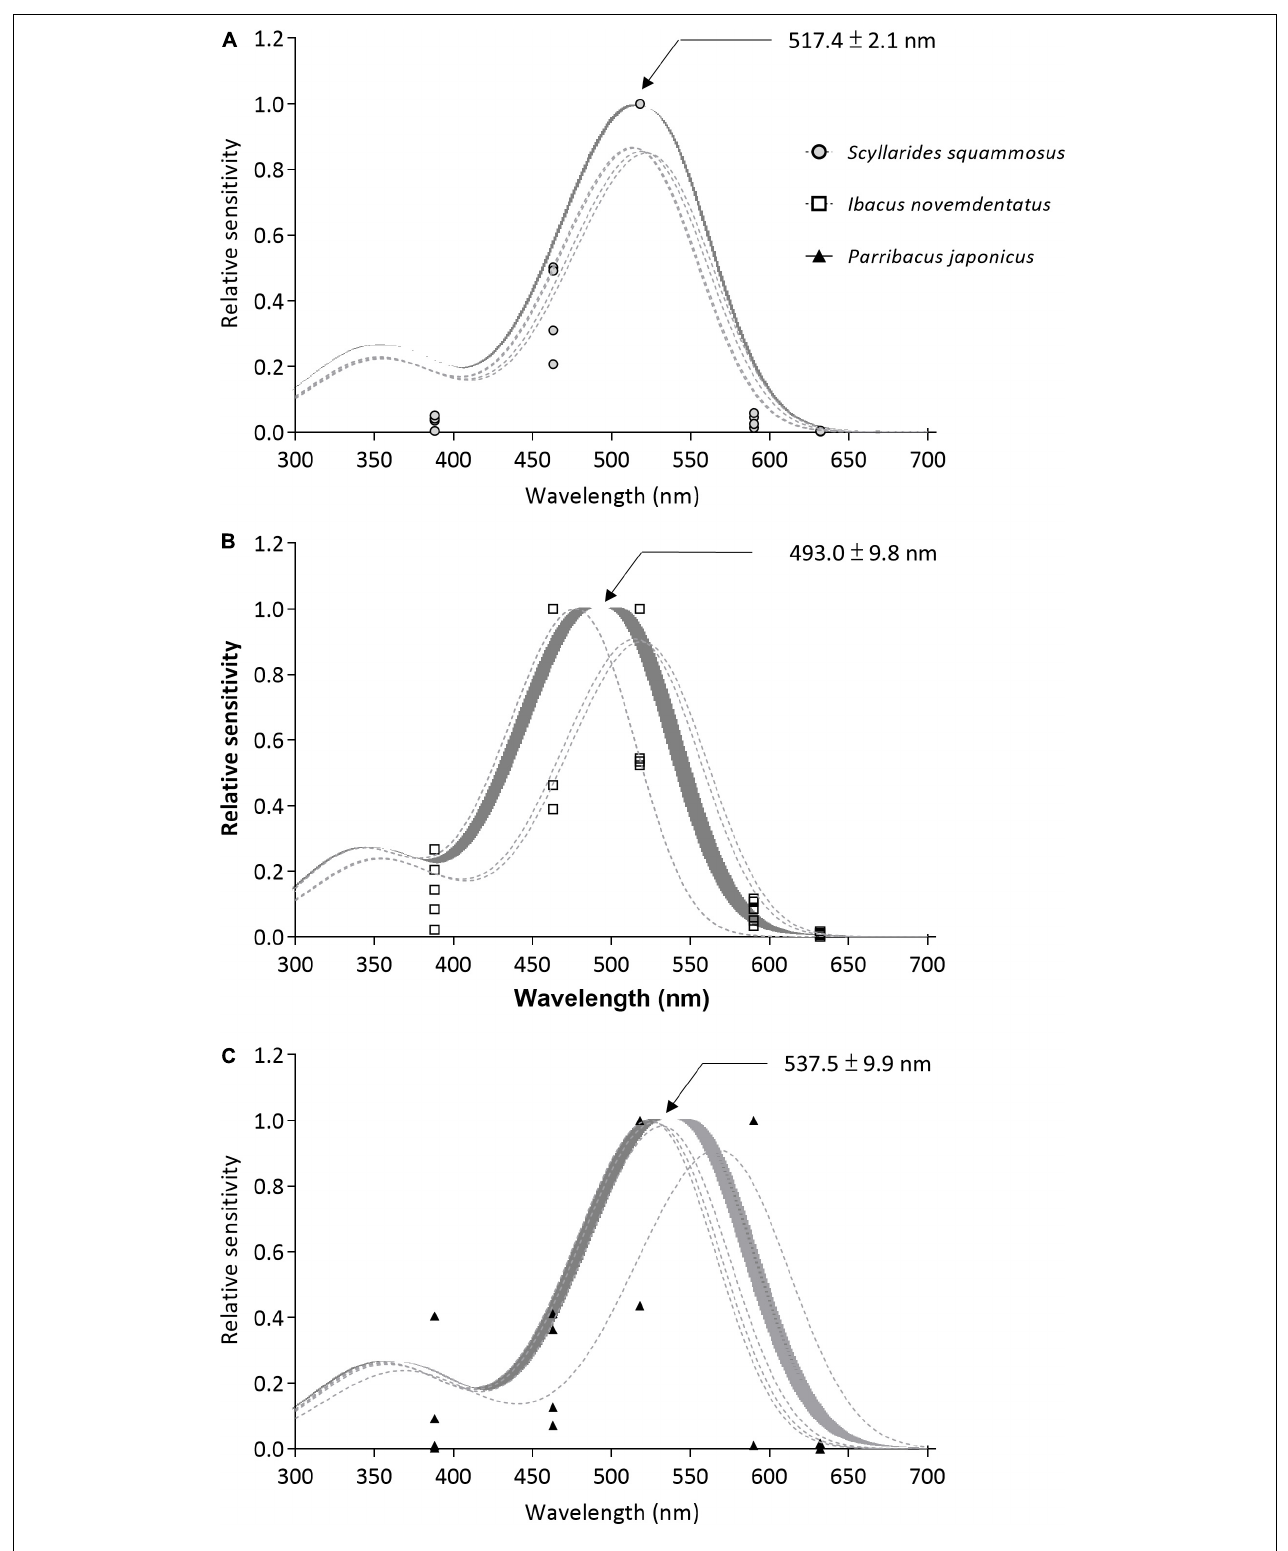
FIGURE 7 | Spectral sensitivity curves. (A) S. squammosus ( n = 4), (B) I. novemdentatus ( n = 5), and (C) P. japonicas ( n = 4). The gray lines indicate curves that were fitted to the sensitivity data of each individual. The solid line shows the curve that was fitted to the mean values, and the shaded area indicates the standard